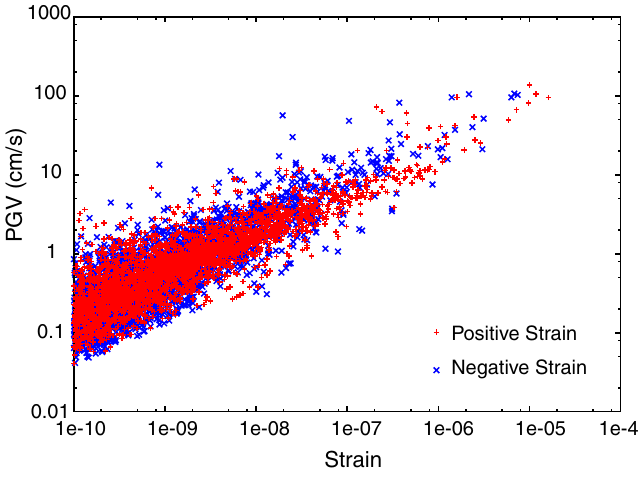
Figure 1. PGV plotted against static strain at volcanoes within distance of 500 km from large